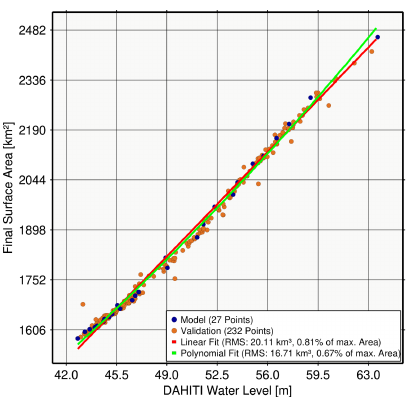
Figure 21. Relation between water level and surface area (hypsometry) used for cross-validation at Tharthar, Lake. The blue points (10% of all points) are used for the function fitting, the orange points for the validation. The two fitted curves are plotted in red (linear fit) and green